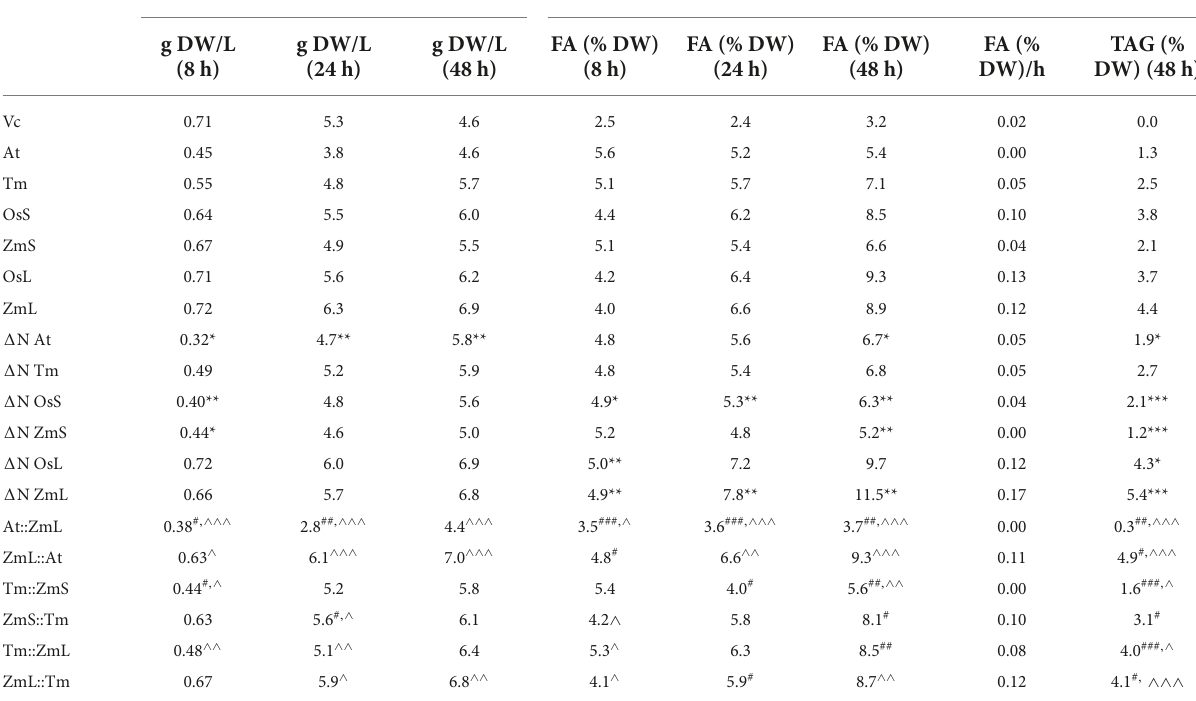
TABLE 1 Influence of expressing full length DGAT1s, (cid:49) N DGAT1s and chimeric DGAT1s in Saccharomyces cerevisiae (quadruple mutant strain H1246, Sandager et al., 2002) on: cell growth (g DW/L); FA content (% DW); FA accumulation rate between 8–48 h (% FA/g DW/h); TAG accumulated at 48 h (% TAG/g